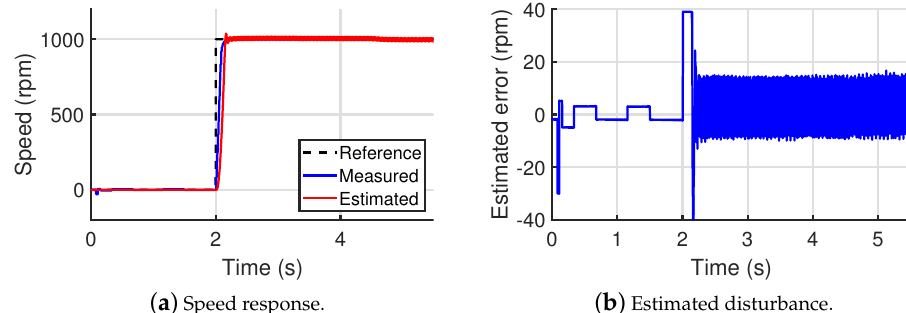
Figure 13. Experimental results of SMO at 1000 rpm.